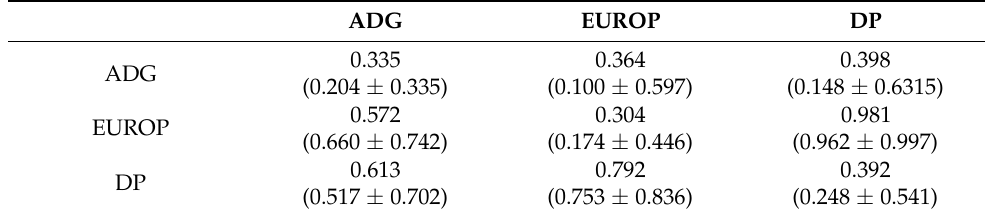
Table 2. Mean of genetic (upper diagonal) and residual (lower diagonal) correlations and heritability (diagonal) between traits in the Rendena population, estimated with PBLUP. Numbers in parenthesis are the lower and the upper 95% highest posterior